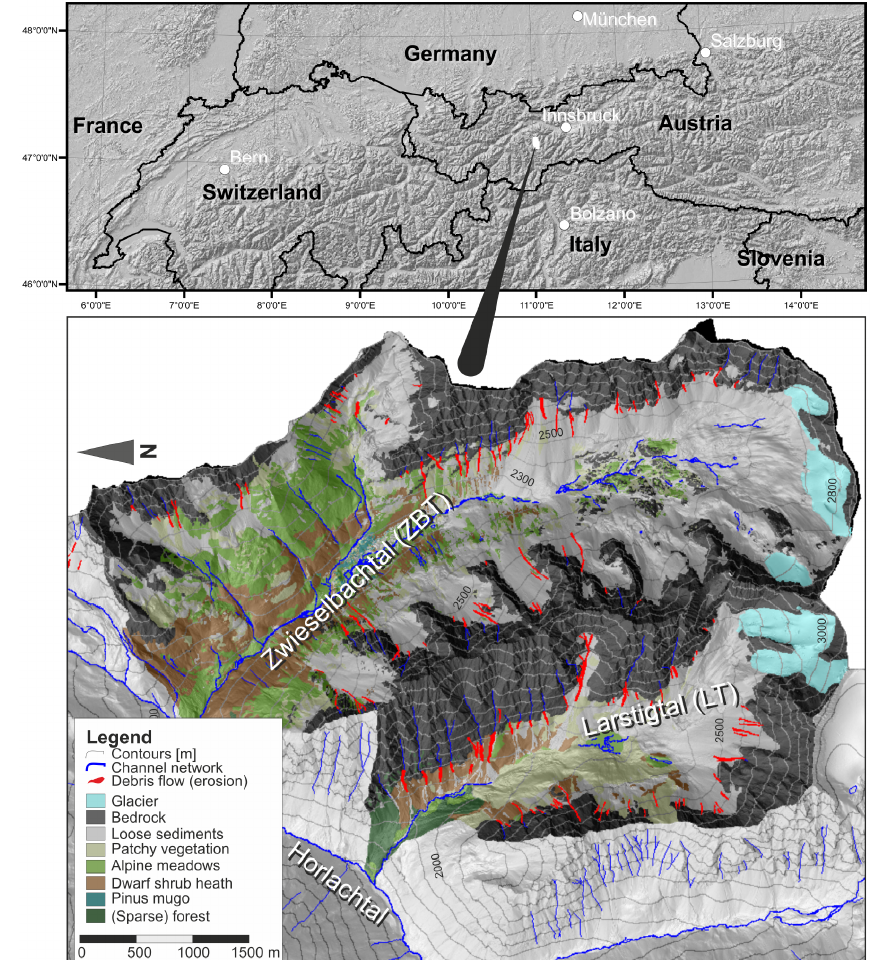
Fig. 1. Overview of the study